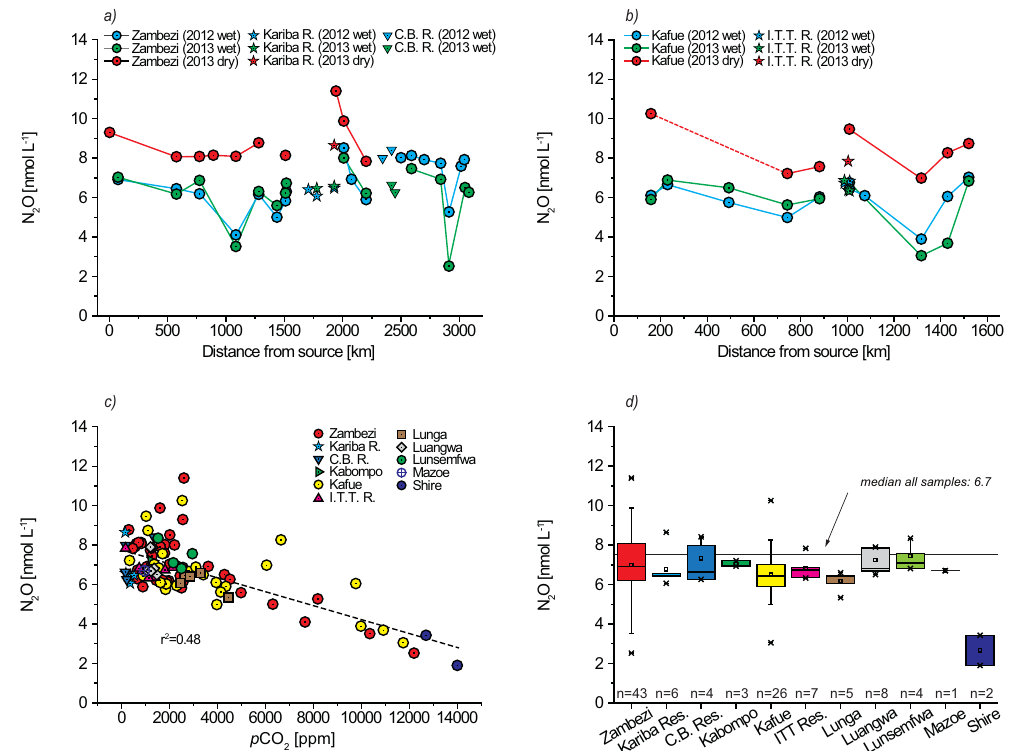
Figure 5. Spatial and temporal variability of N 2 O along (a) the Zambezi River, including the Kariba Reservoir (Kariba R.) and Cahora Bassa Reservoir (C. B. R), and (b) the Kafue River, including the Itezhi Tezhi Reservoir (I. T. T. R.). Panel (c) shows the correlation between N 2 O and p CO 2 . Panel (d) shows overall (all campaigns) range N 2 O concentration for the Zambezi River, tributaries and reservoirs. Box plots show range, percentile, median, mean and outliers. The solid line represents median N 2 O value (6.7µmolL − 1 ) of all sites during the entire sampling